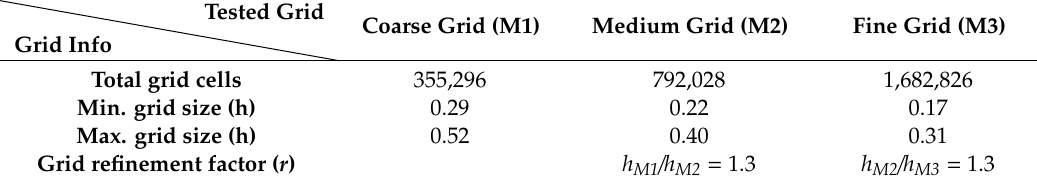
Table 1. Tested gird for mesh sensitivity study.